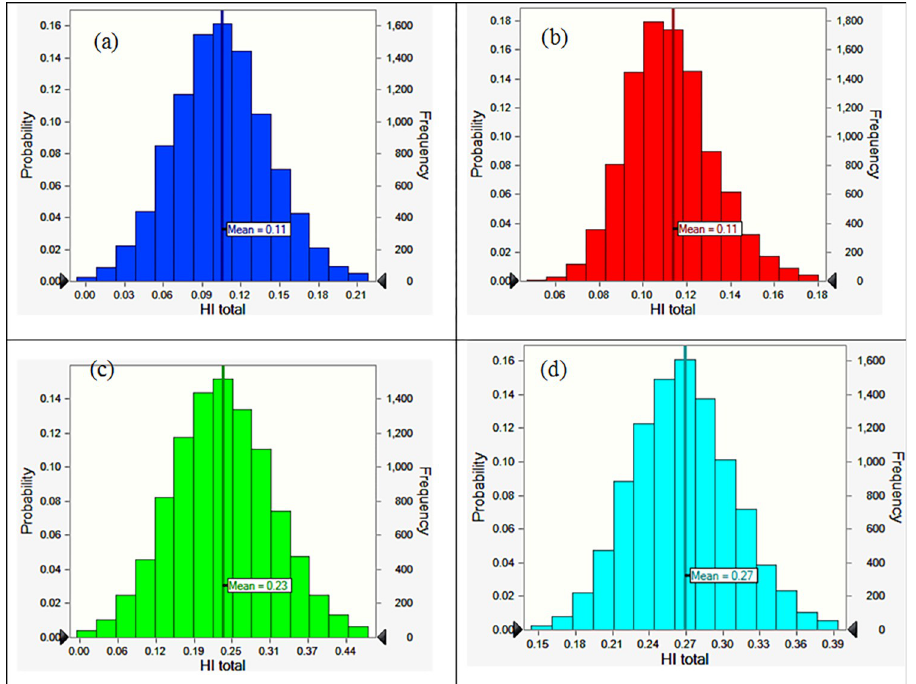
Fig 2. Cumulative distribution of the HI total of heavy metals for (a) vegetables irrigated with TWW for children, (b) vegetables irrigated with TWW for adults, (c) vegetables irrigated with IWW for children, and (d) vegetables irrigated with IWW for